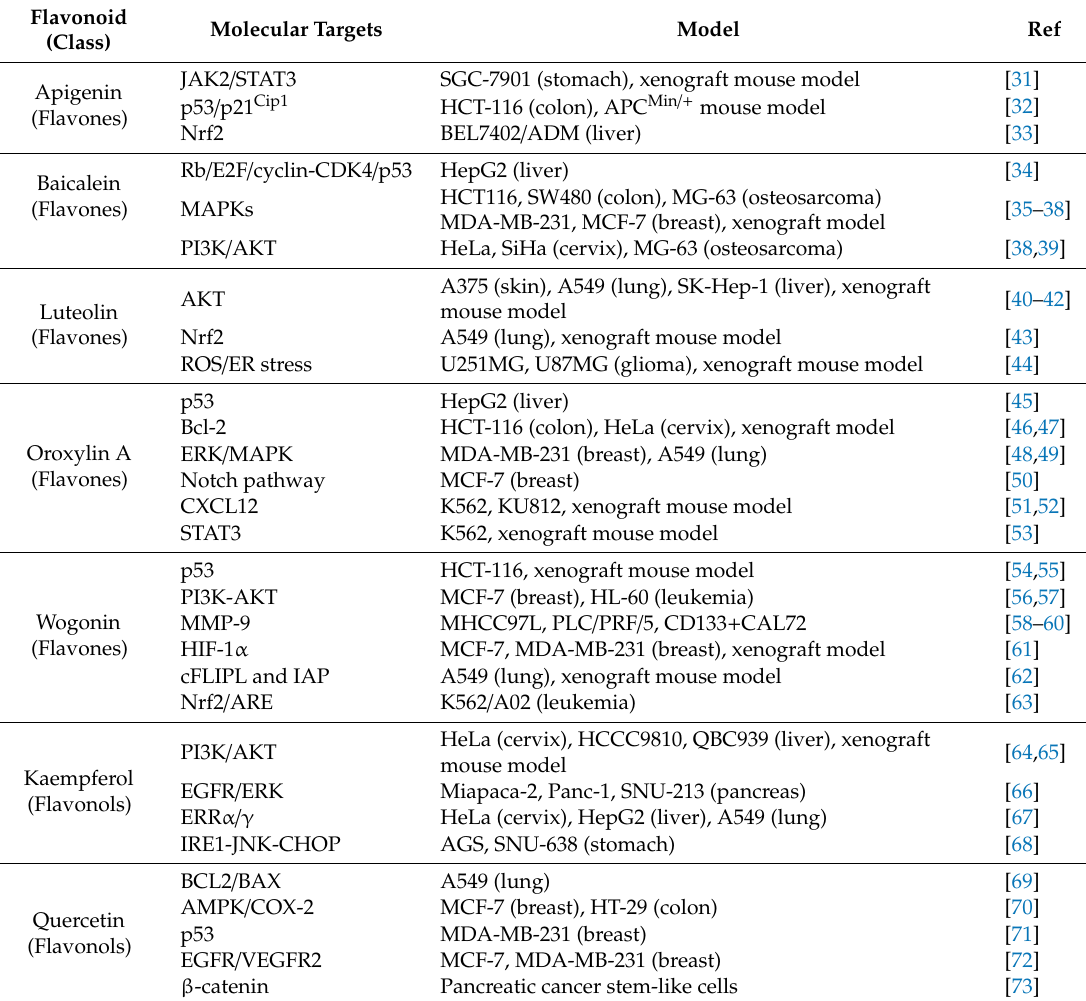
Table 1. Molecular targets of flavonoids to exert anticancer e ff